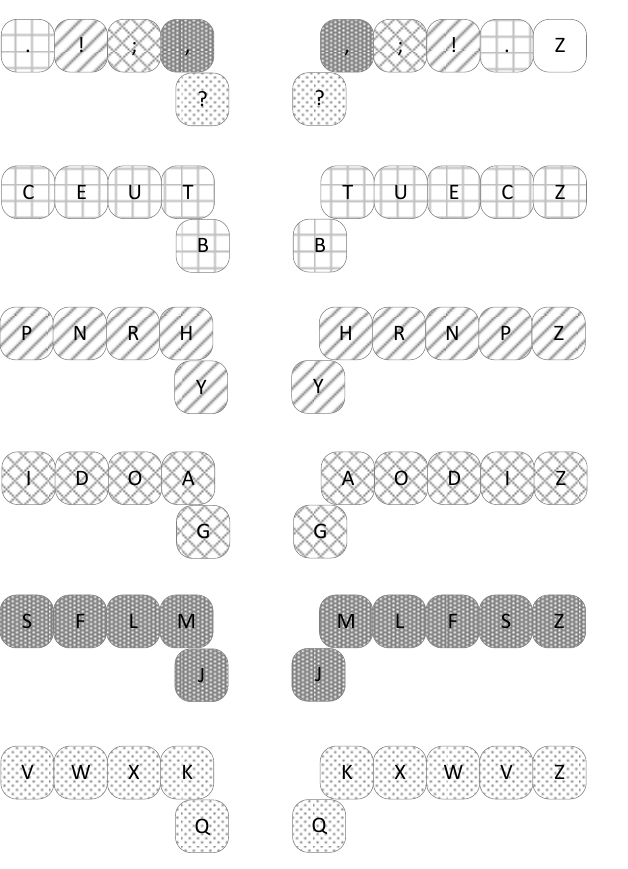
Figure 10. My-W-ORK+ arrangement.